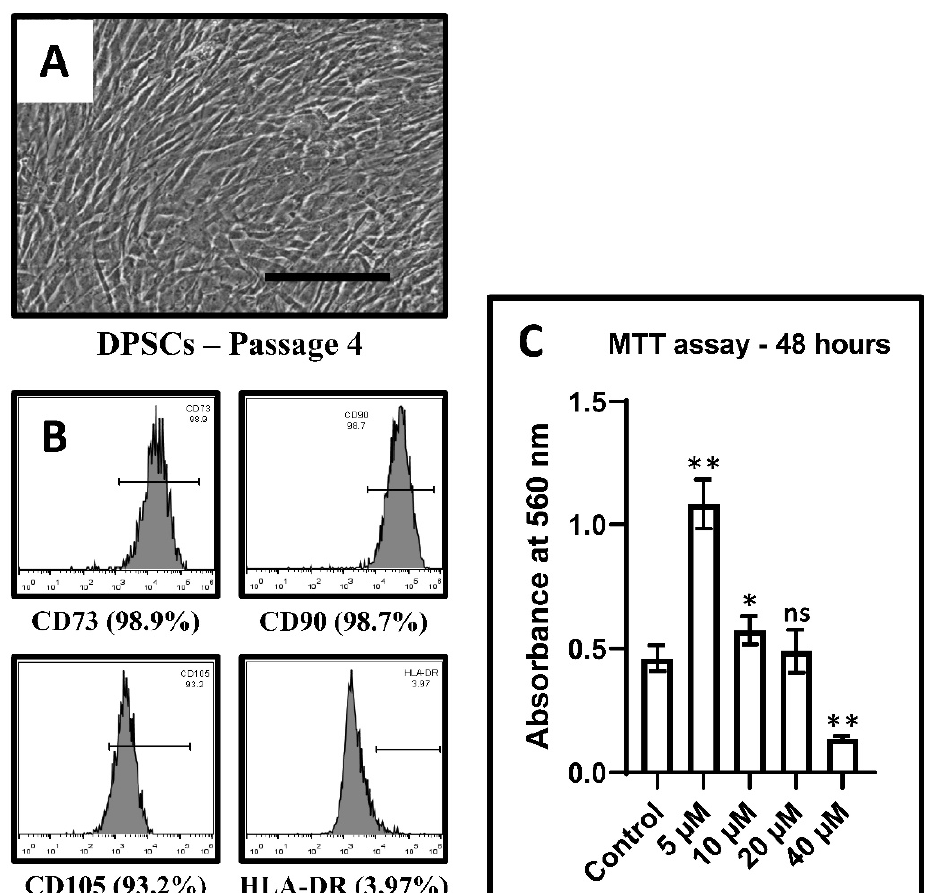
Figure 1. ( A ): elongated spindle-shaped morphology of the isolated cells; ( B ): MHC II class repre- sentation; ( C ): cell viability at high concentration of CoCl 2 . ns not significant, * p < 0.05, and ** p < 0.01.